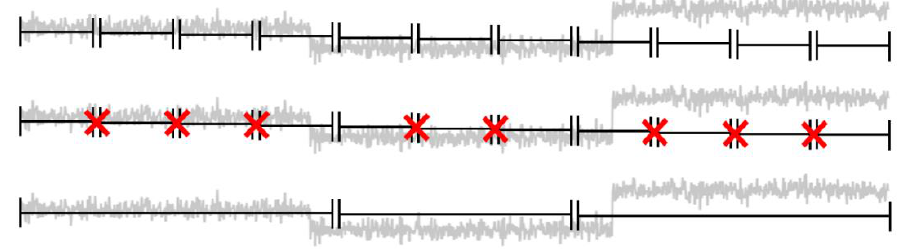
Figure 8. Bottom-up algorithm schema based on [5].